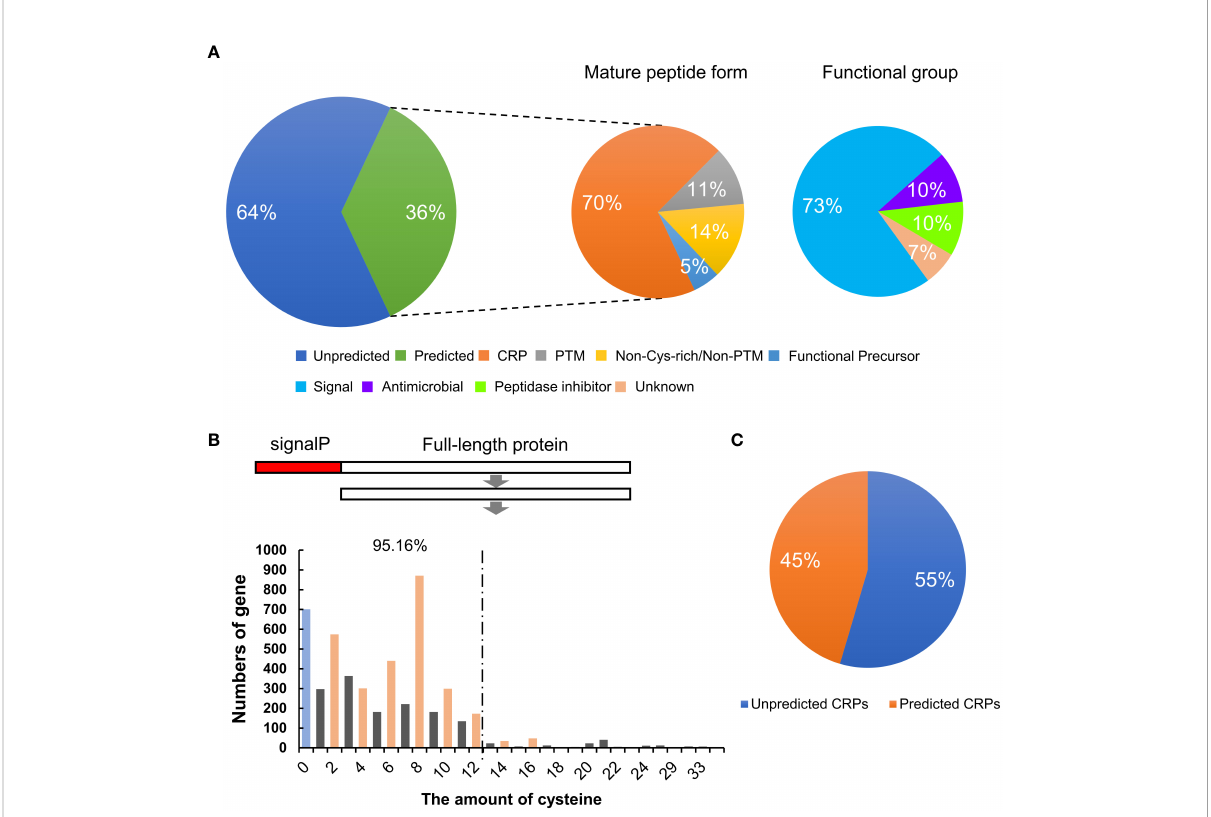
FIGURE 1 Identi fi cation and classi fi cation of SSPs in wheat. (A) The percentage of different types and functional groups of TaSSPs predicted in MtSSPdb (https://mtsspdb.noble.org/database/). CRP, cysteine-rich peptide; PTM, post-translational modi fi ed. (B) The amount of TaSSPs with different number of cysteines after deleting signal peptide sequences. SignalP, signal peptide. 95.16% indicates the percentage of TaSSPs with 2, 4, 6, 8, 10 and 12 cysteines to all putative CRPs. (C) The percentage of putative unpredicted CRPs and predicted CRPs in